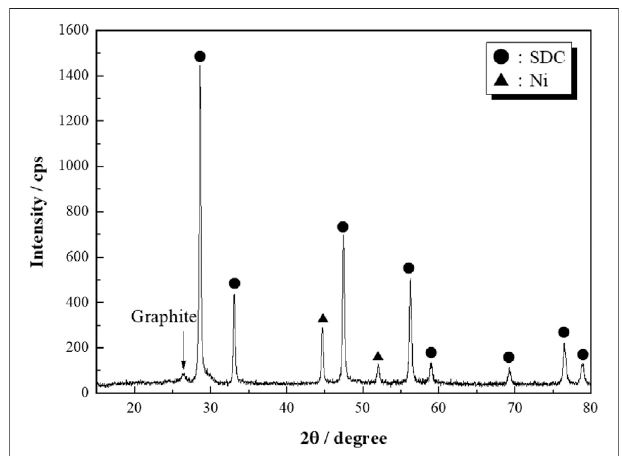
FIGURE 10 | XRD pattern of the Ni/SDC powder after CH 4 exposure at 700 °